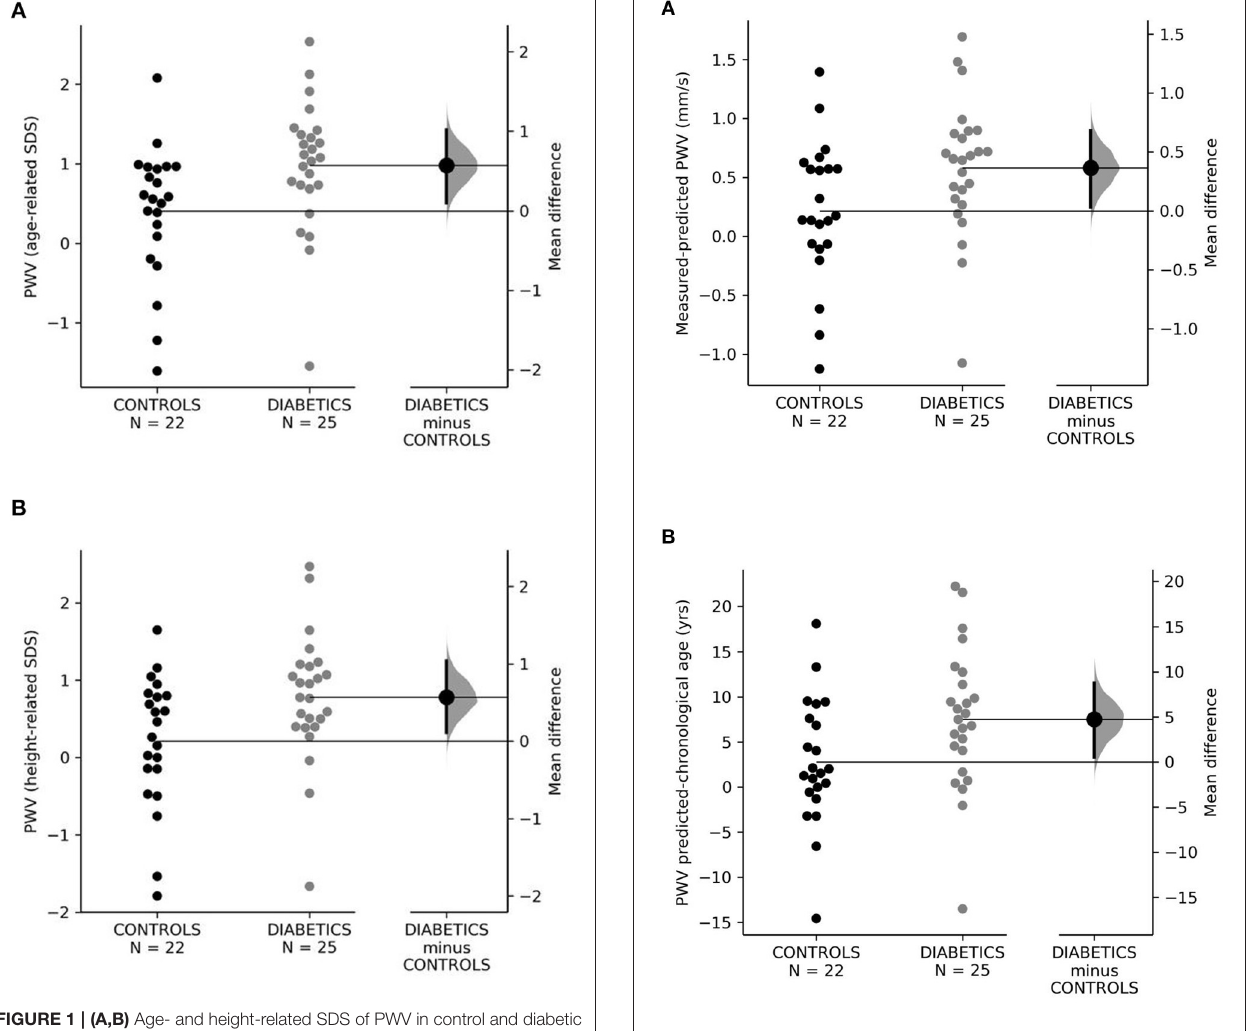
significantly higher